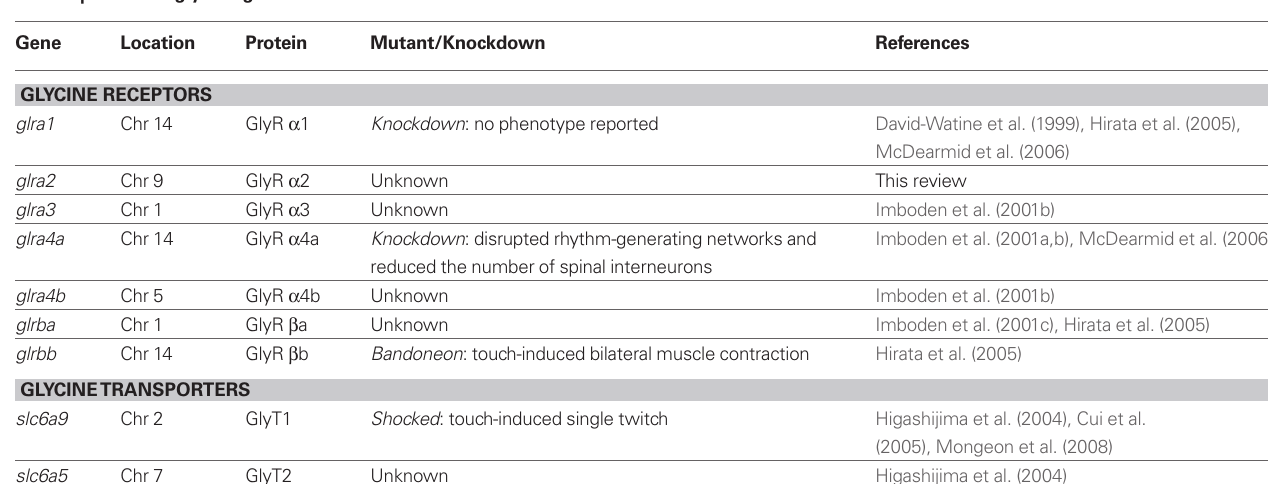
Table 3 | Zebrafi sh glycinergic transmission.